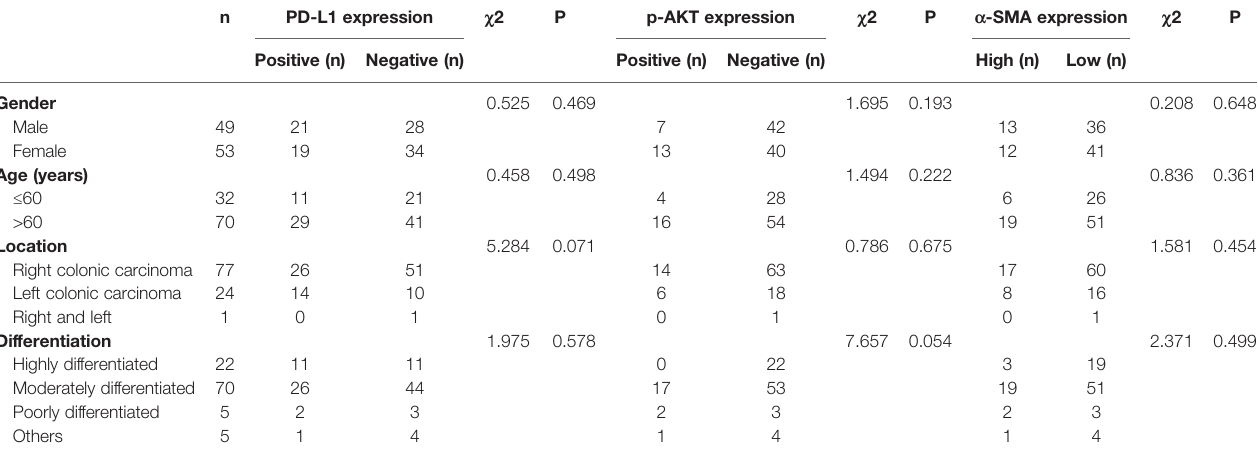
TABLE 1 | Relationship between PD-L1, p-AKT and a -SMA expression and clinicopathological characteristics in 102 patients with CRC.